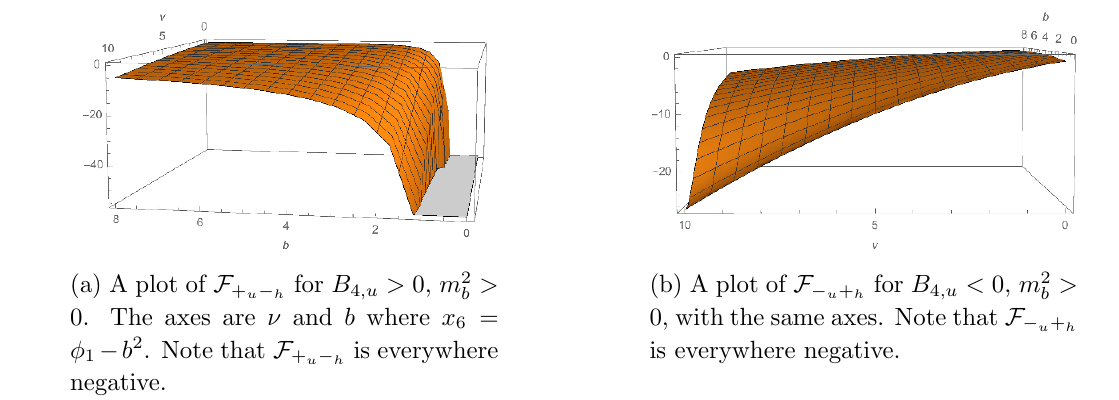
Figure 28. Numerical evaluation of the free energy di(cid:11)erence between two competing phases.